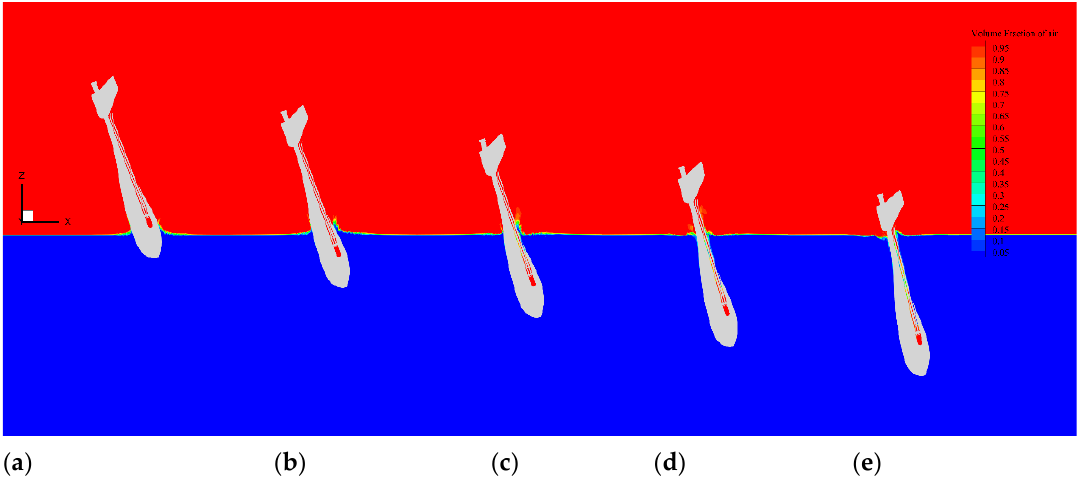
( d ) ( e ) Figure 17. Free surface profiles of the vehicle entering water at θ 0 = 80° at different times: ( a ) t = 0.10 s, ( b ) t = 0.15 s, ( c ) t = 0.20 s, ( d ) t = 0.25 s, and ( e ) t = 0.30 s.